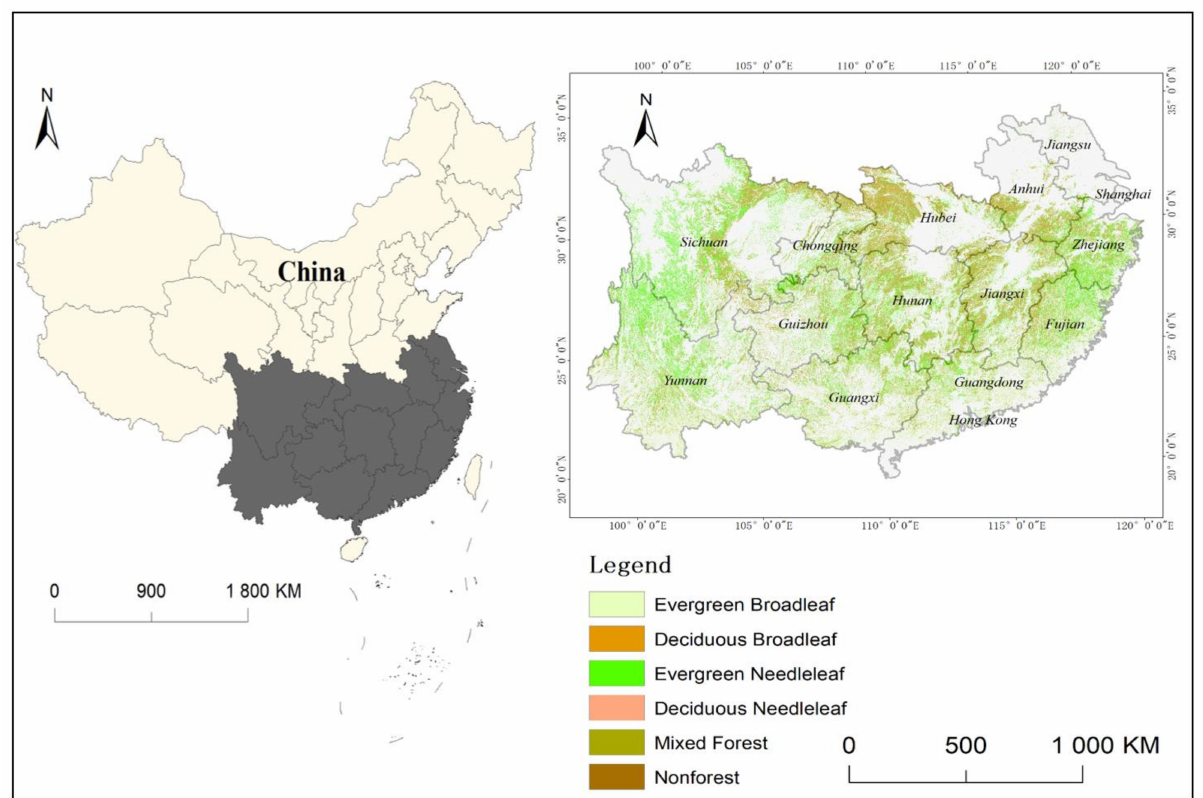
Figure 1. Forest distribution in southern China in